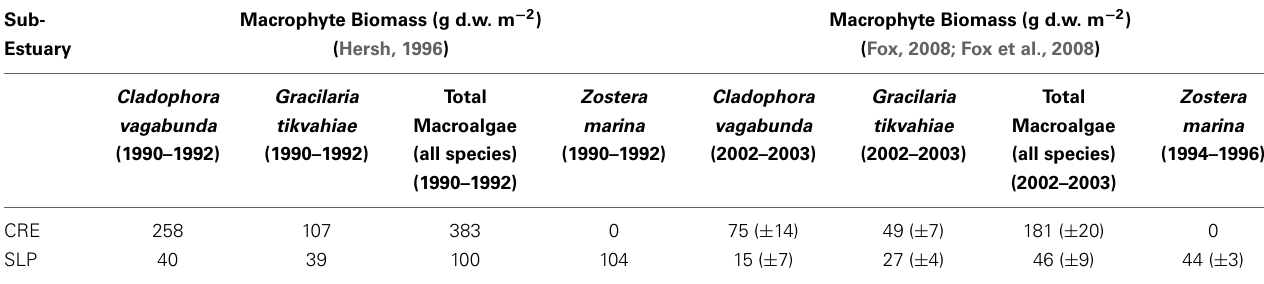
Table 3 | Comparison of mean macrophyte biomass in grams dry weight per meter squared (g d.w. m − 2 ) between surveys conducted in the early 1990s (Hersh, 1996) and the early 2000s (Fox, 2008; Fox et al.,